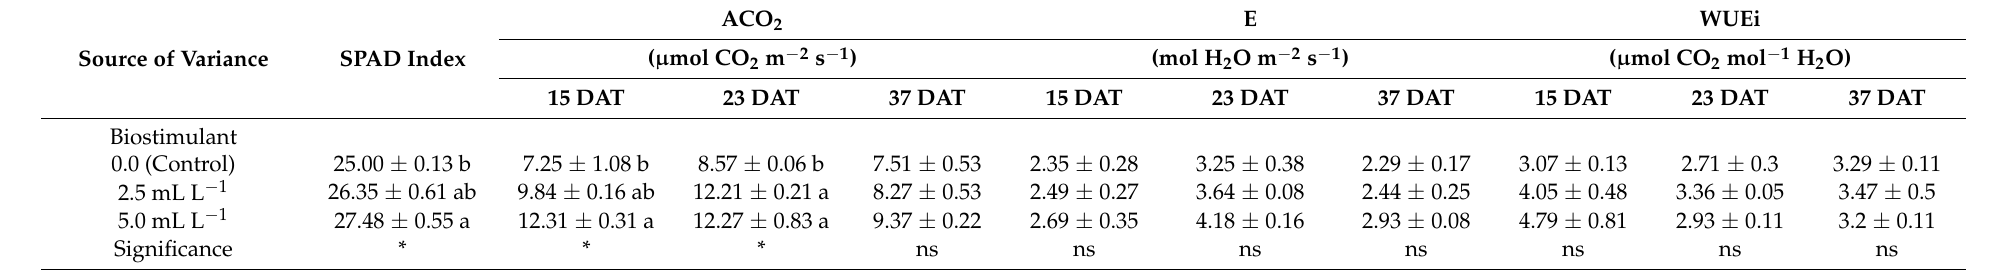
Table 1. The analysis of variance and mean comparisons for physiological parameters of greenhouse lettuce cultivated under three biostimulant doses.